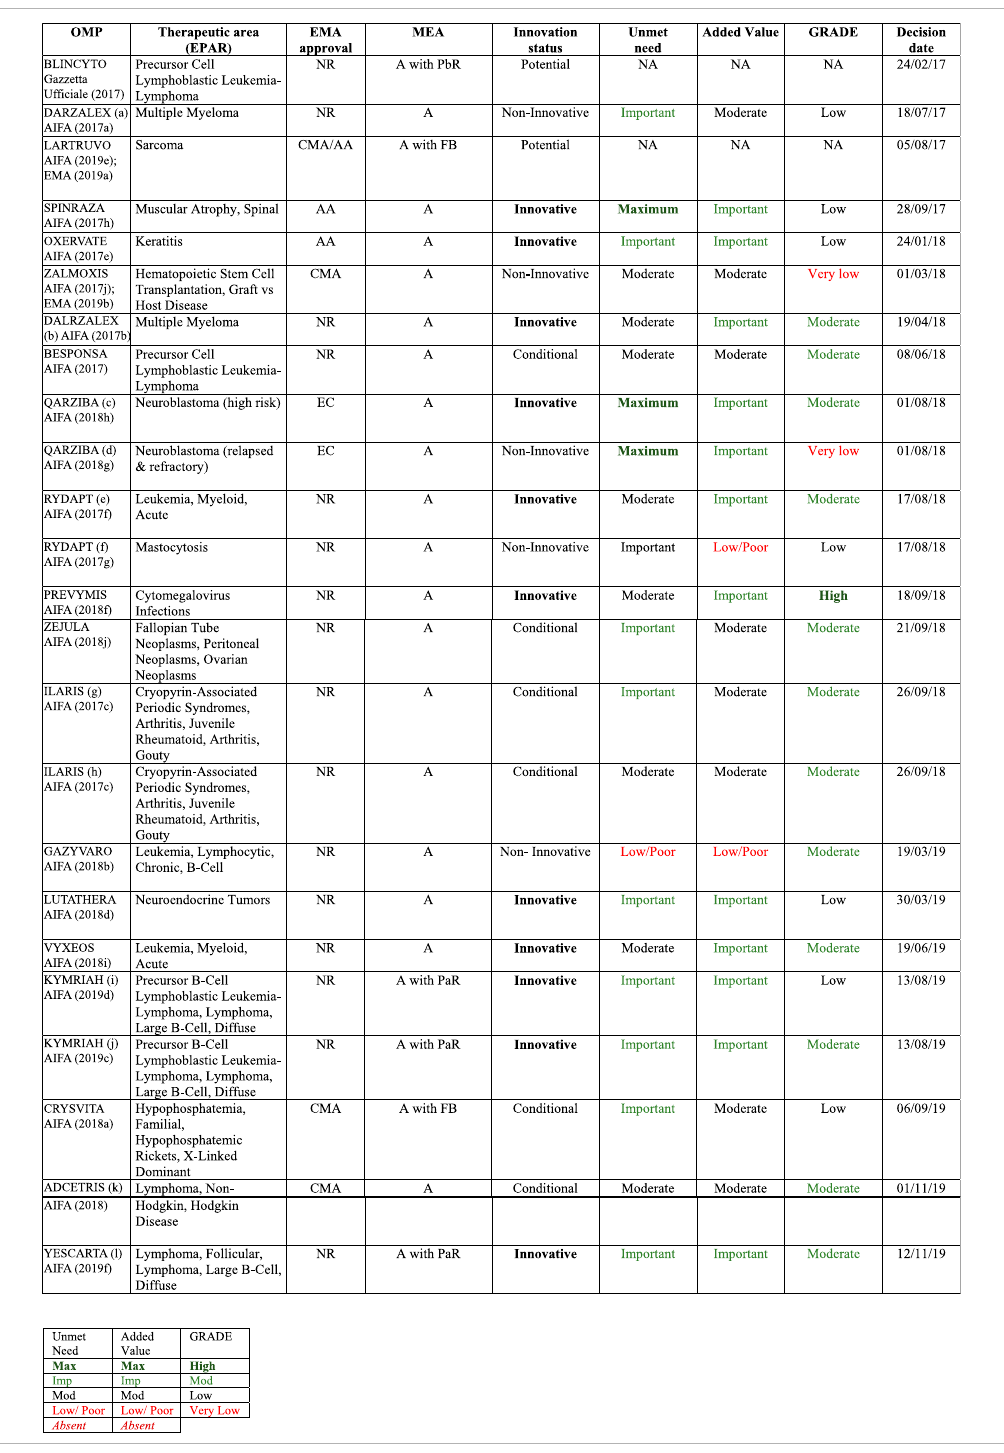
TABLE 2 | OMPs registries and innovation status (2017 – 2019